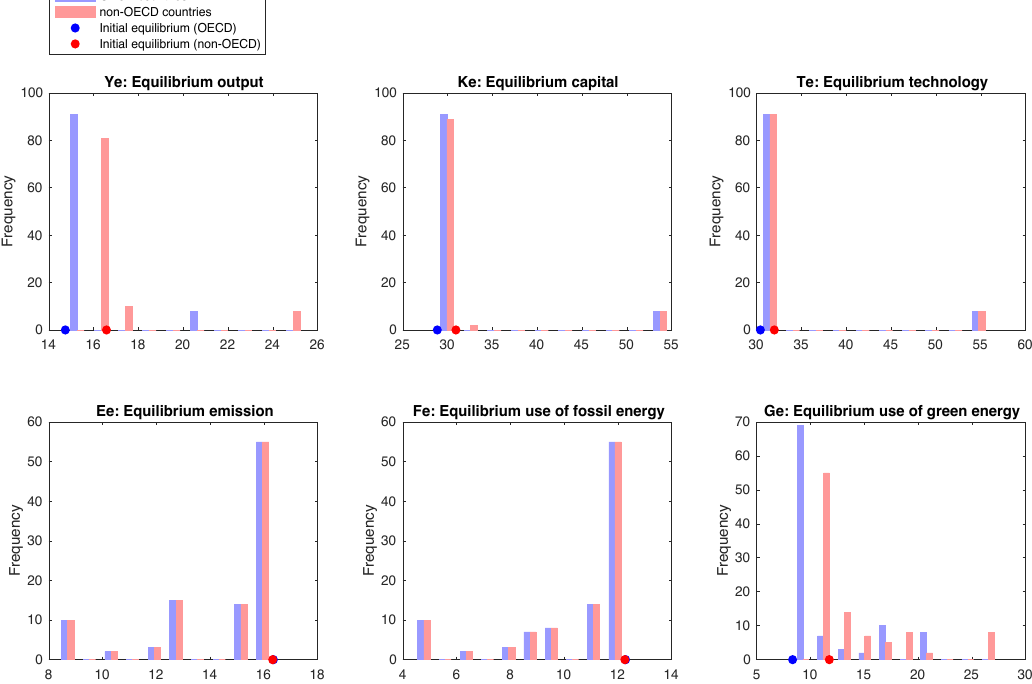
Figure A4. Equilibrium values with stochastic π i